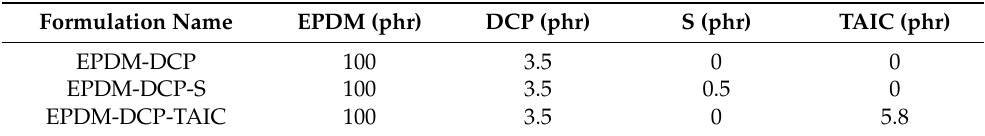
Table 1. Formulations of EPDM rubber.